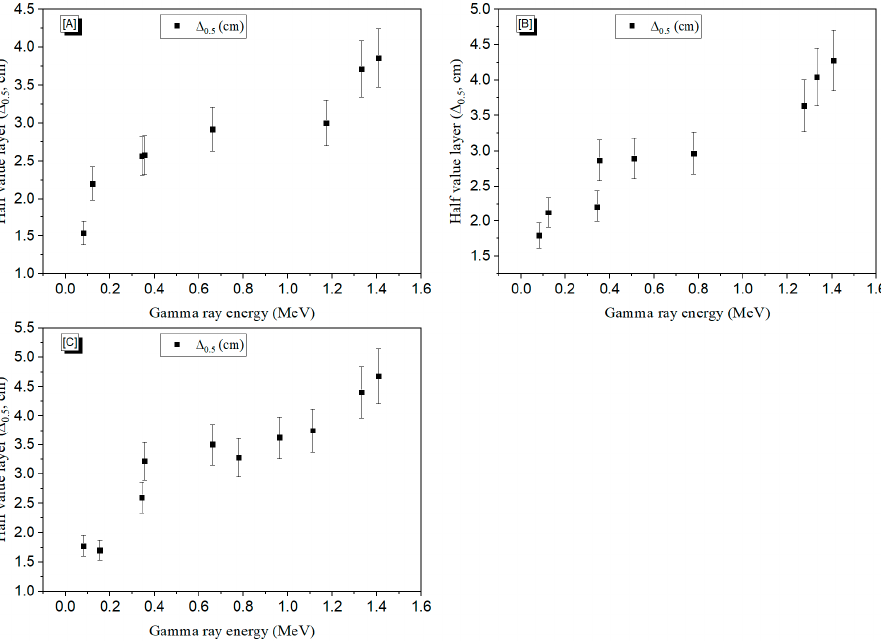
Figure 8. The variation of HVL ( Δ 0.5 ) with the incoming gamma energy for concretes ( A ), ( B ), and ( C ) with W/C ratios of 0.4, 0.6, and